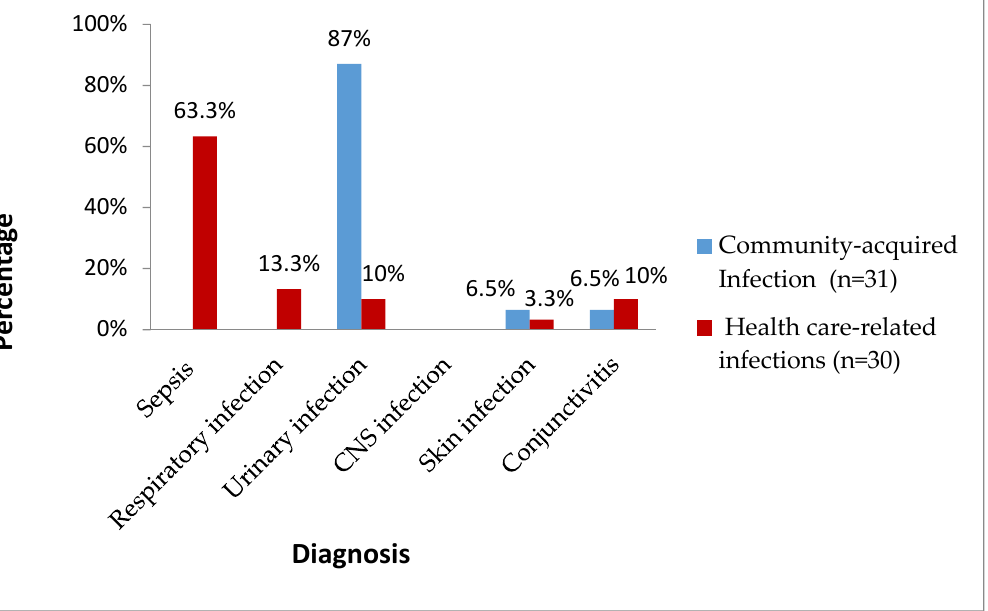
Figure 1. Clinical forms and origin of neonatal infections by Gram-negative bacilli. Havana, 2017–2018.